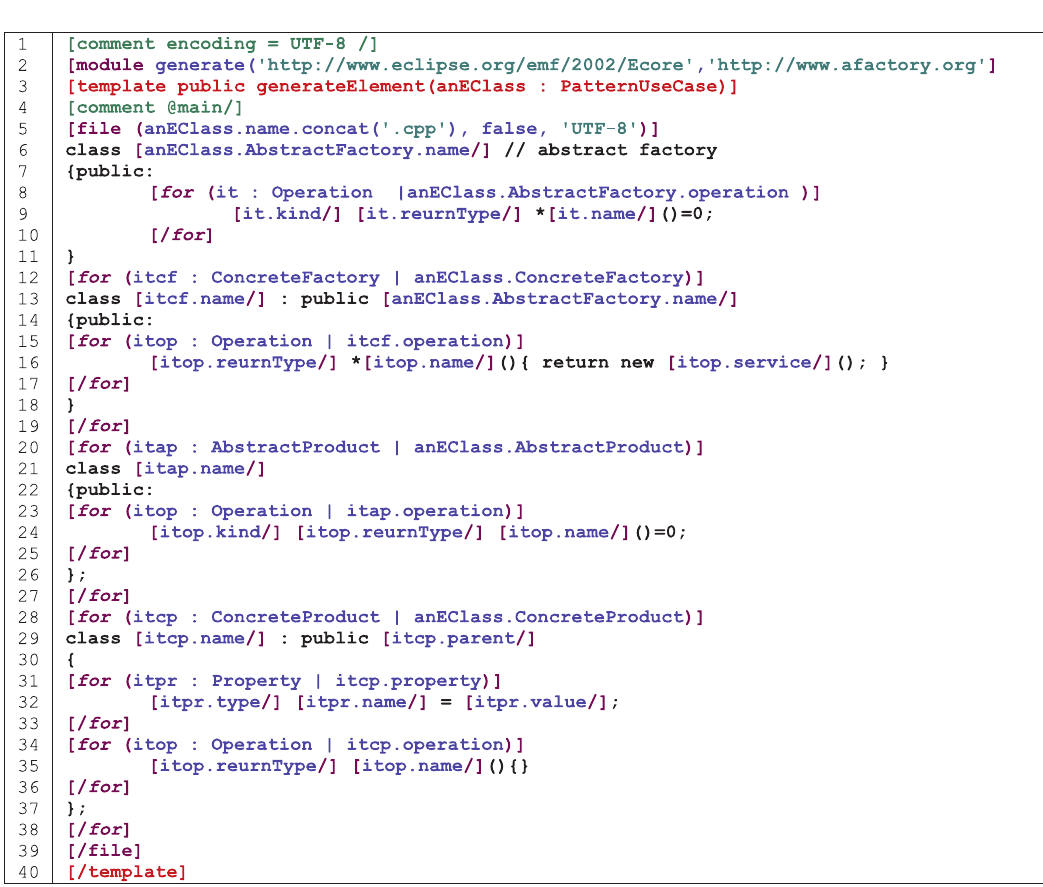
Figure 30: Abstract factory